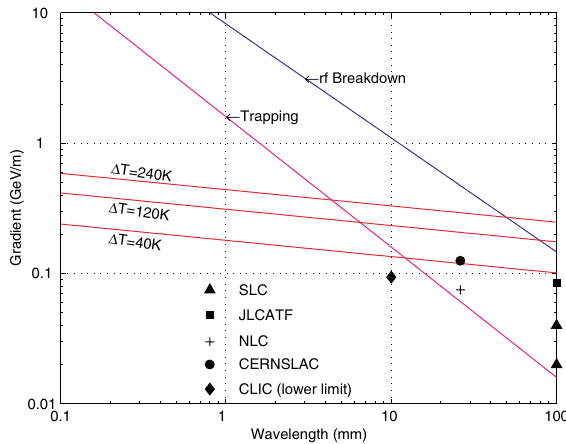
FIG. 1. (Color) Gradient limits due to rf breakdown, dark current trapping, and pulsed heating. The data points represent gradient achieved with reasonable dark current [2]. The gra- dient limit for pulsed heating assumes a damage threshold of (cid:25) T (cid:2) 40 K and is scaled from parameters of the Next Linear Collider (NLC) assuming the filling time scales as T